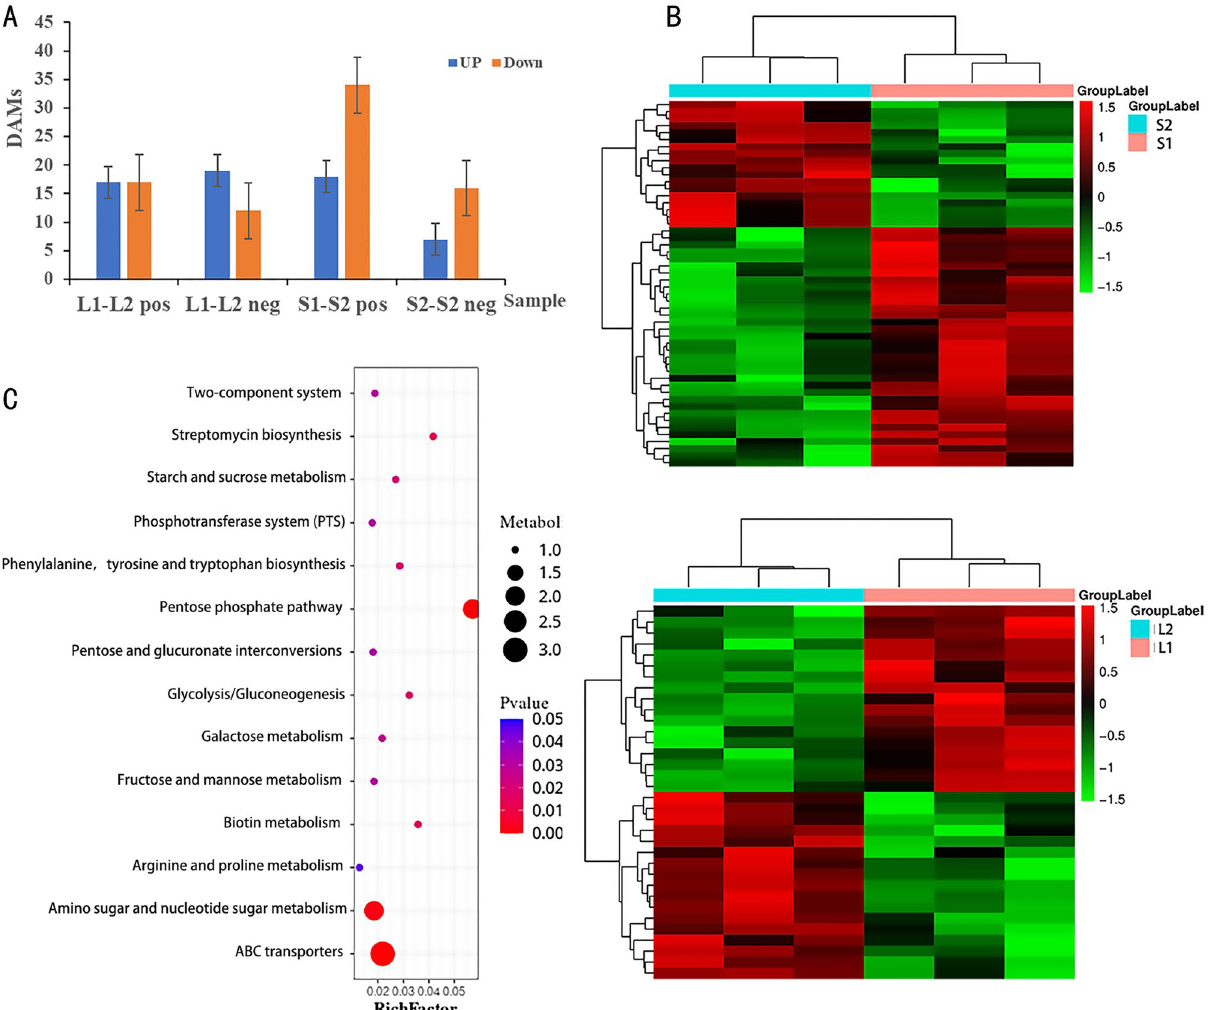
Figure 5. (A) Statistical map of differential metabolites (DAMs). (B) The Hierarchical cluster analysis of differential accumulated metabolites (DAMs) in L1–L2, S1–S2 of S. miltiorrhiza . (C) Bubble Diagram of metabolic pathway enrichment analysis in